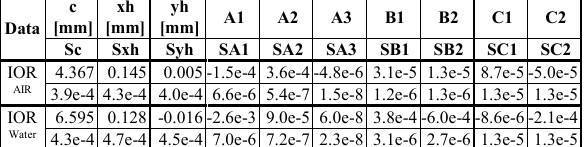
Table 5. Interior orientation parameters and their standard deviation of left camera of bundle adjustment using standard